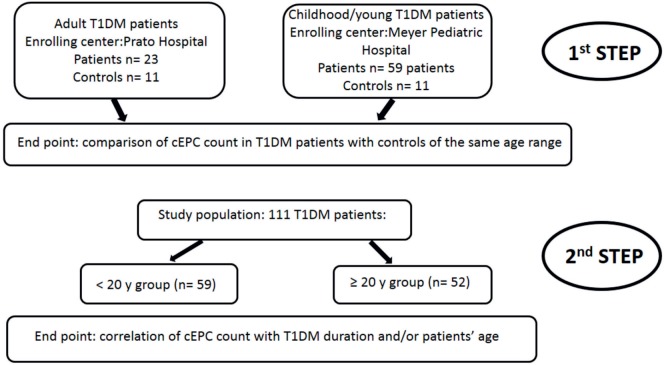
Flow diagram showing the rationale of the study. The end point of the first step of the study was the evaluation of the number of circulating endothelial progenitor cells (cEPCs) in adult and childhood/young patients, compared to age-matched controls. In the second step of the study, the end point was the association of the number of cEPCs with disease duration and/or patients’ age.